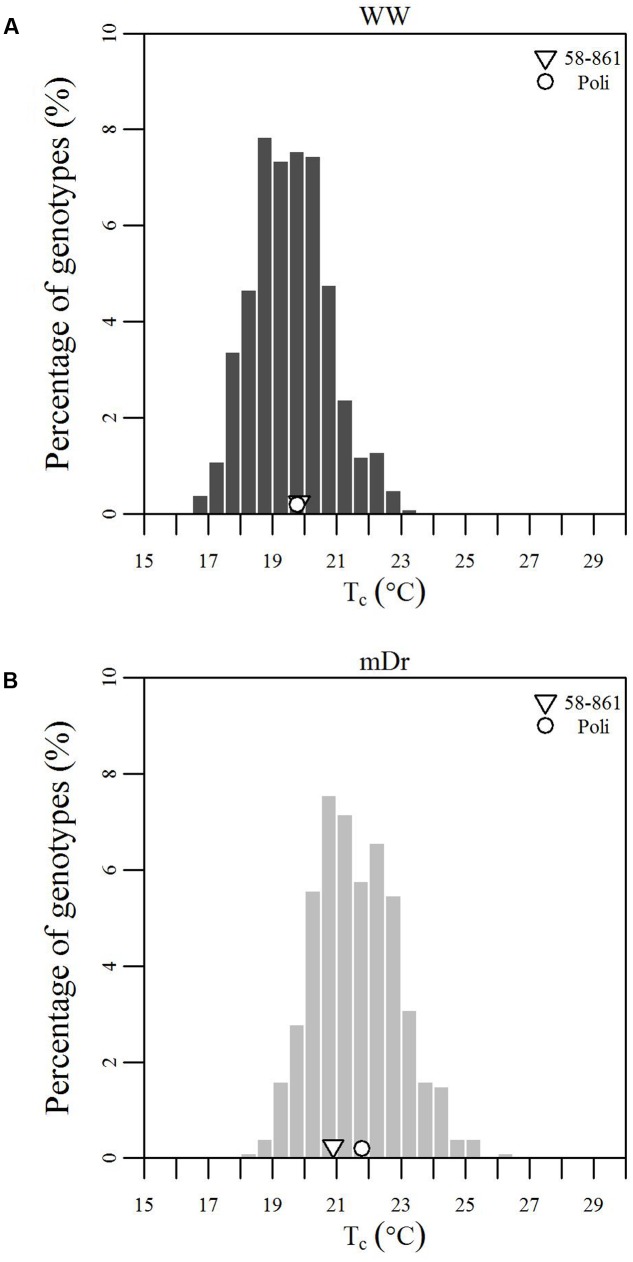
Frequency distributions of genotypic mean Tc (°C). (A) eCognition data for WW and (B) mDr conditions. Histogram bins are 0.5°C in width. The triangle and circle indicate genotypic mean Tc for 58-861 and Poli, respectively.